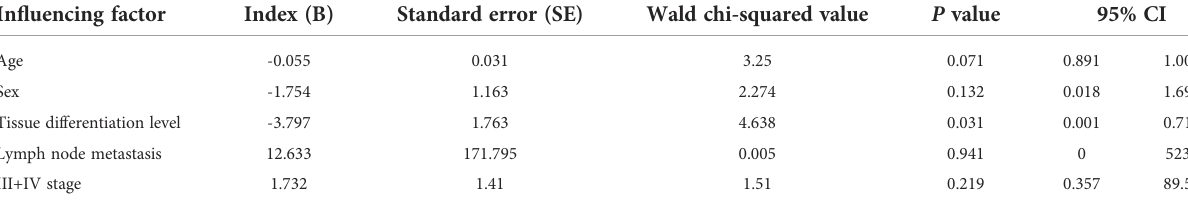
TABLE 3 Multivariate Cox regression analysis of patients with pulmonary mucoepidermoid carcinoma. In fl uencing factor